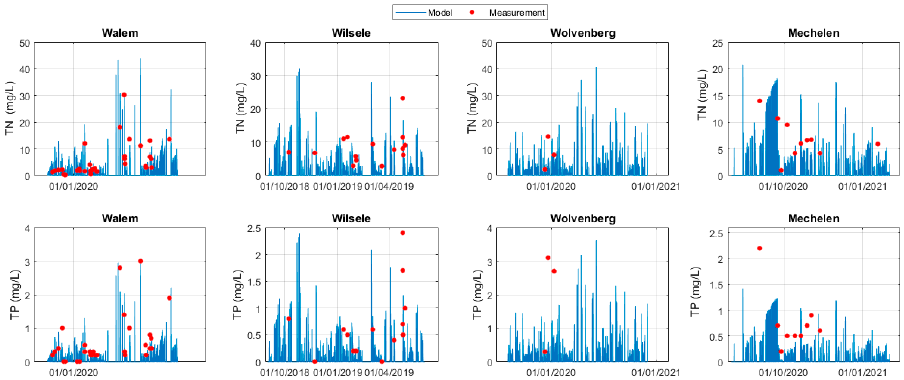
Figure 5. Modeled and measured heavy metals and TSS concentrations in different catchments. Model1 shows the concentrations derived by the WEISS method, without assuming a maximum build up, whereas in model 2, a maximum build up is incorporated.